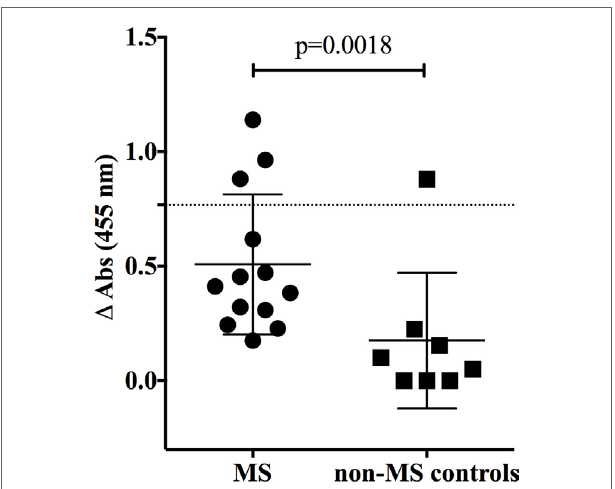
FigUre 1 | Ms and control-derived rigg binding to neurofilament light (nF-l) by solid phase elisa . MS-derived rIgG ( n = 13) and control rIgG ( n = 8) derived from a germinoma were tested by solid phase ELISA for binding to NF-L. The specific samples included in the assay are shown in the Supplementary Material. Each dot or square represents the binding of a single rIgG. The dashed line indicates the mean + 2 SD of the control germinoma-derived cohort (0.76). Values above this line were determined to be positive (95% CI). To correct for non-specific binding, the reported ELISA signal ( Δ OD) was calculated by subtracting the signal generated by binding to glyceraldehyde 3-phosphate dehydrogenase (GADPH) from that of the NF-L. The mean and SD are shown for each data set. Statistical differences are indicated when significant. Data associated with each rIgG for the MS and control groups are shown in the Supplementary